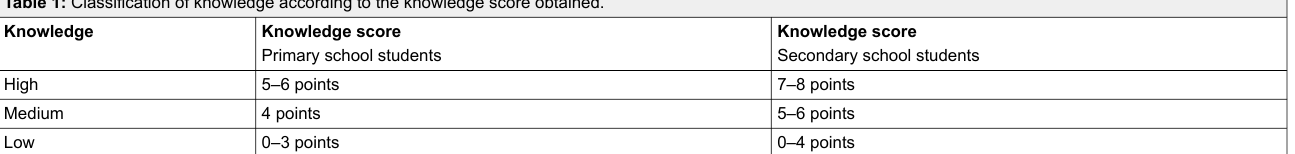
Table 1: Classification of knowledge according to the knowledge score